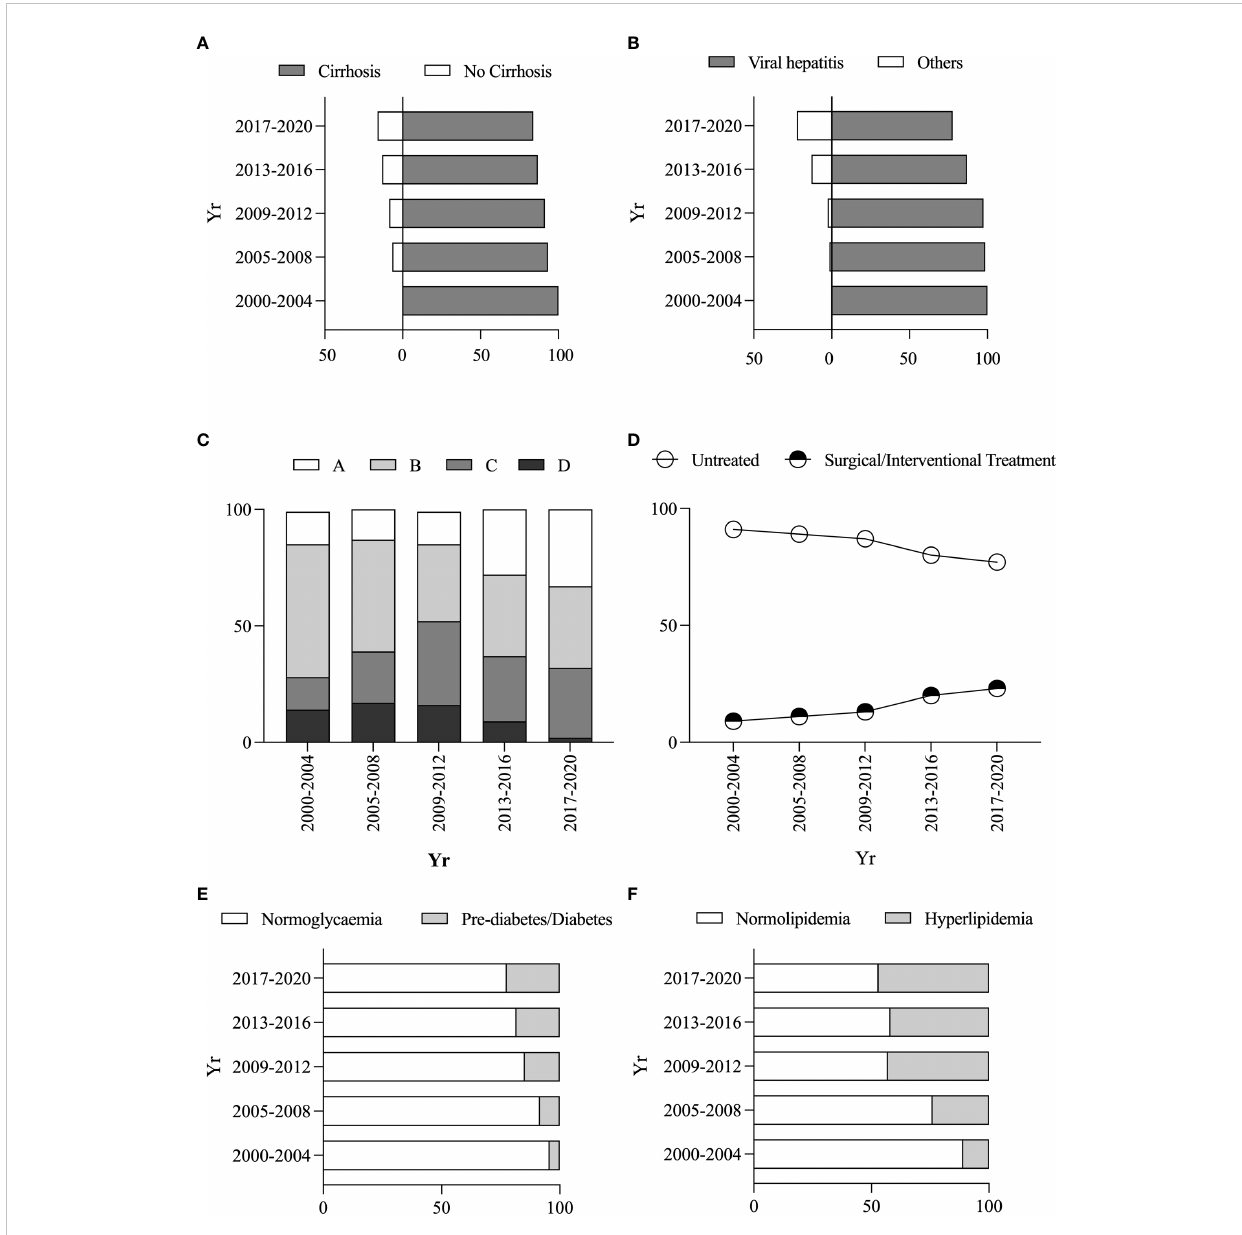
FIGURE 3 Changes in clinical characteristics and metabolic risk factors of PLC patients. Changes in the proportion of combined vs without cirrhosis (A) . Changes in the proportion of non-/viral hepatitis-related PLC patients (B) . Changes in the proportion of different BCLC stages (C) . Changes in the proportion of different treatment protocols (D) . Changes in the proportion of pre-diabetes/diabetes vs normoglycemia (E) . Changes in the proportion of hyperlipidemia vs normolipidemia (F)